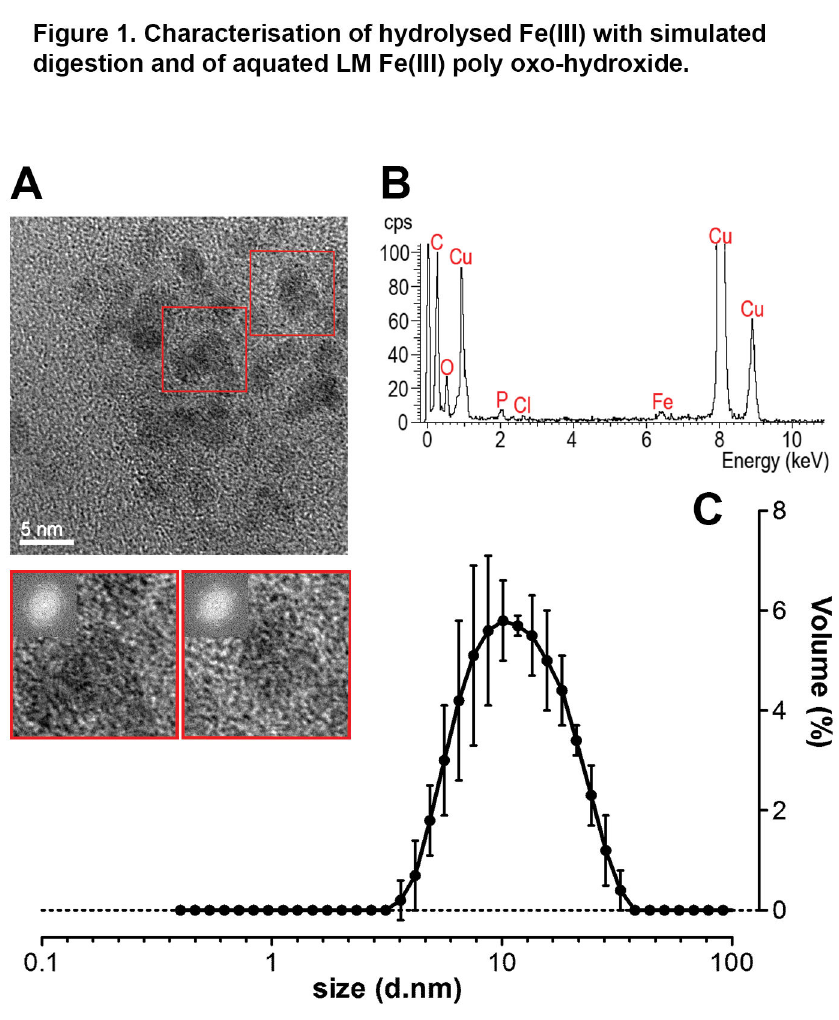
Figure 1. Characterisation of hydrolysed Fe(III) with simulated digestion and of aquated LM Fe(III) poly oxo-hydroxide. A , Transmission Electron Microscopy (TEM) images collected from a drop of suspension after simulated digestion of 1 mM Fe(III) chloride in the presence of 2 g/L mucin and low molecular weight ligands. The boxed regions are shown magnified below and highlight the presence of fine, poorly crystalline nanoparticles dispersed in an amorphous gel. Crystallinity is indicated by the spots in the inset diffractograms (fast Fourier transforms) in the boxed regions and lattice spacings are discussed in the main text. Scale bar represents 5 nm. B , Whole area EDX analysis of a particle agglomerate similar to those in ‘A’ shows elemental compositions (the specimen support film and grid produce the background C and Cu signals respectively). C , Hydrodynamic size distribution of nanoparticulate 500 µM LM Fe(III) poly oxo-hydroxide in balanced salt solution (BSS) measured by Dynamic Light Scattering (DLS). Values are expressed as mean diameter ± s.d. (3 independent measurements) on a log 10